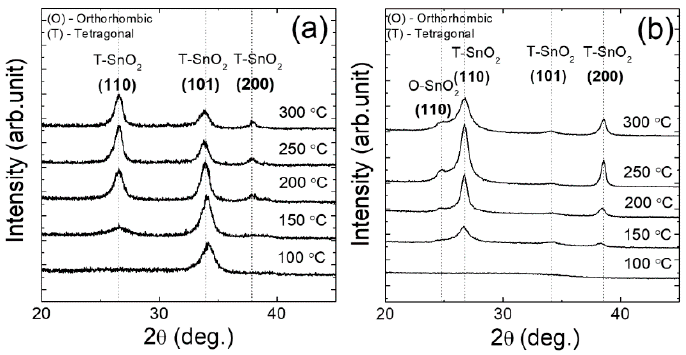
Figure 6. Glancing-angle X-ray diffraction (GAXRD) patterns of ( a ) SH-SnO 2 and ( b ) SO-SnO 2 thin films deposited at different temperatures of 100, 150, 200, 250, and 300 °C.